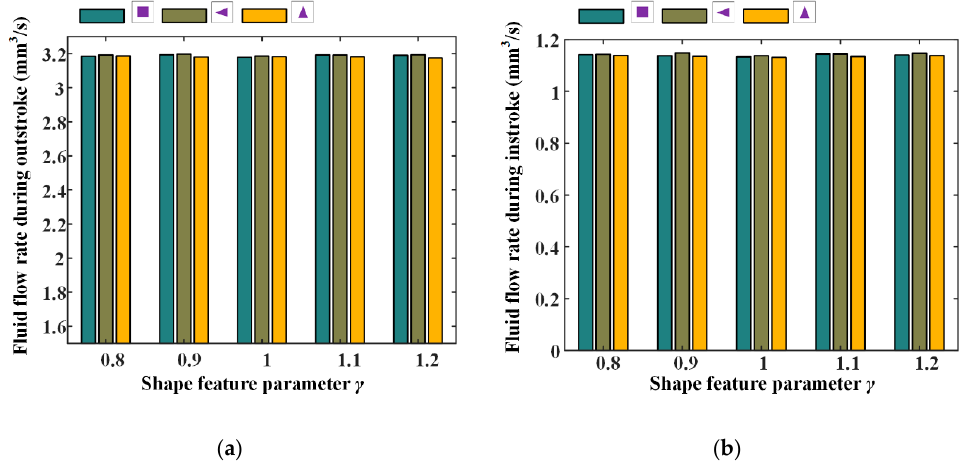
Figure 24. The relationship between wear time rate and texture shape parameter, ( a ) outstroke, ( b ) instroke.